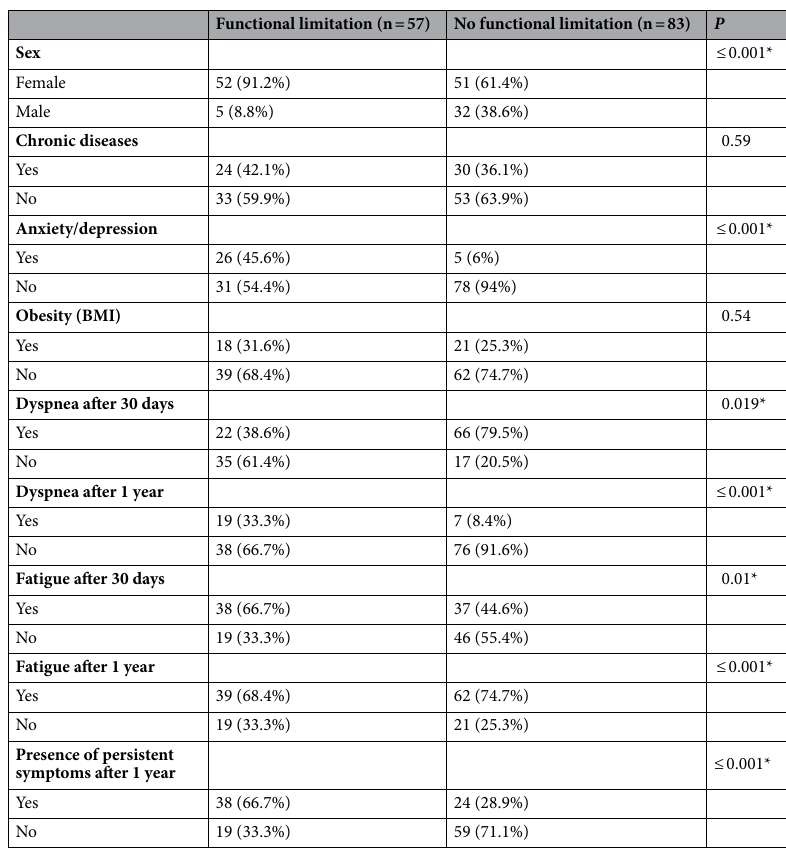
Table 3. Univariate association between functional status limitations after one year and sex, comorbidities, persistent symptoms, fatigue, and dyspnea. Source : Prepared by the authors (2022). Chart legend: BMI: body mass index, * P ≤ 0.05. For comparisons between groups, the independent t test or the Mann ‒ Whitney U test was used.